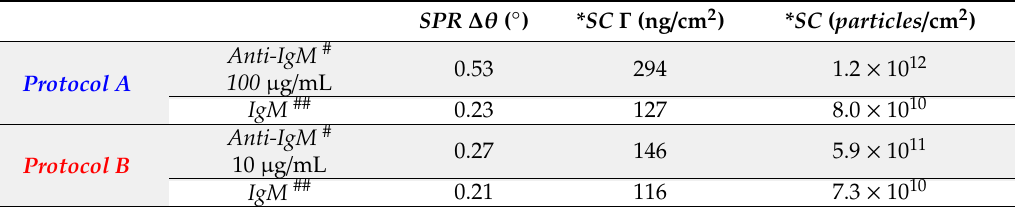
Table 1. Surface plasmon resonance (SPR) response as angle shift ( ∆ θ ) recorded for the anchored anti-human immunoglobulin M (IgM) and IgM exposure in nM range for both protocols. Calculated surface coverage expressed in ng / cm 2 and number of immobilized molecules for cm 2 surface